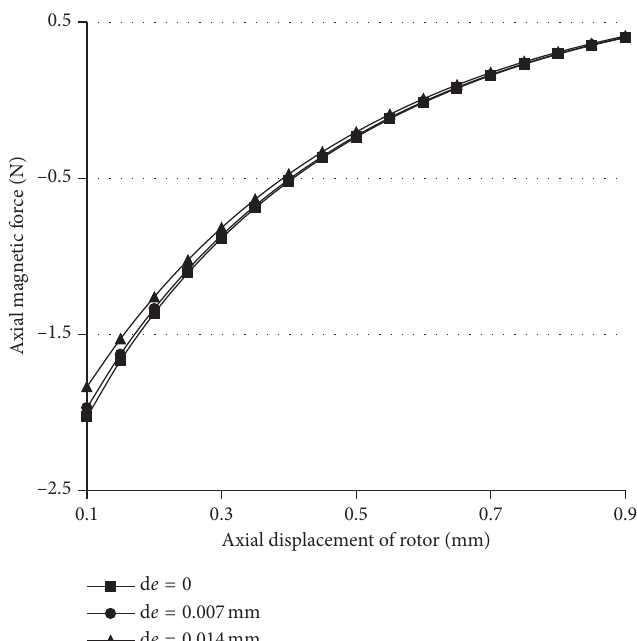
Figure 6: Axial forces of magnetic bearing 1 acting on the rotor in different axial positions and deflections around z -axis. –0.08–0.0400.040.08